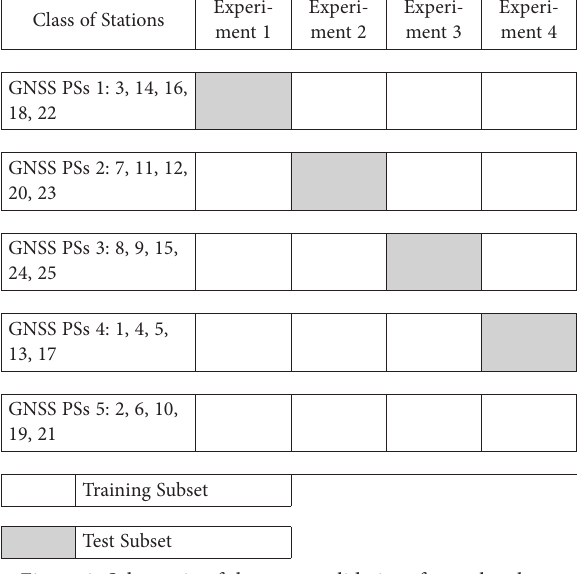
Figure 3. Schematic of the cross-validation: for each subset, the identification number (the same reported in Table 1) of each GNSS PS included is